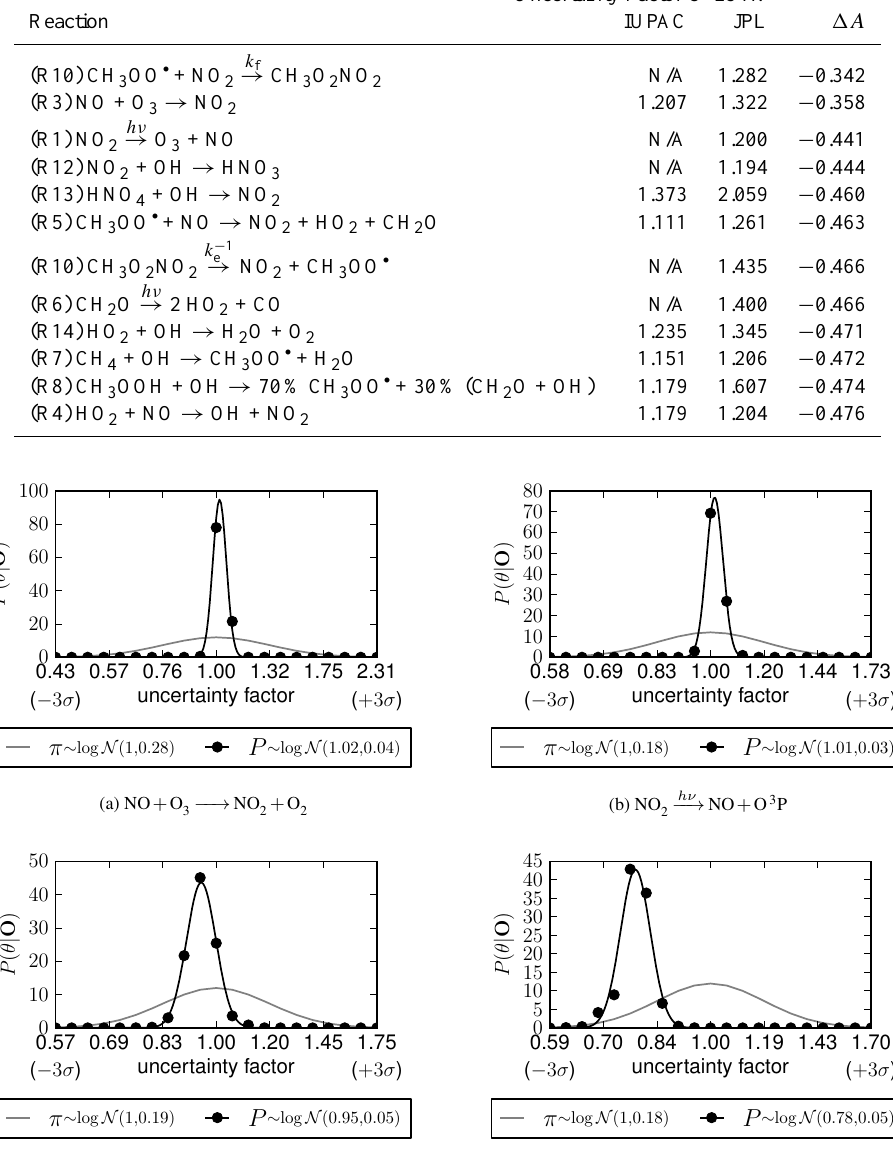
Uncertainty Factor @ 234K